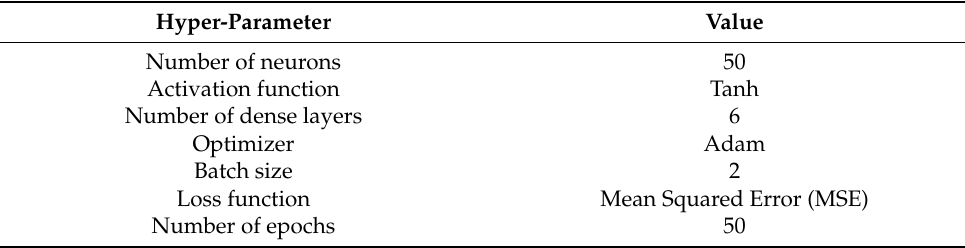
Table 3. CNN tuning